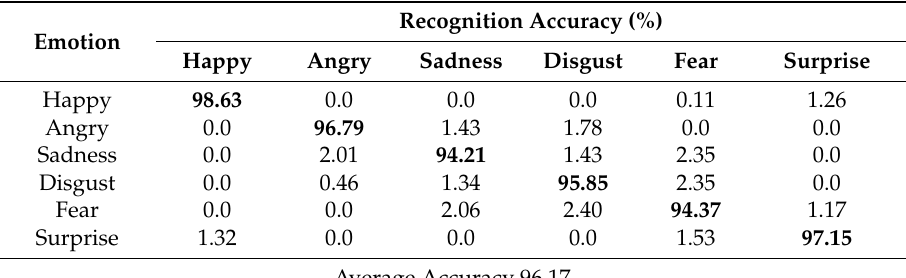
Table 7. Confusion matrix for the Cohn–Kanade database.